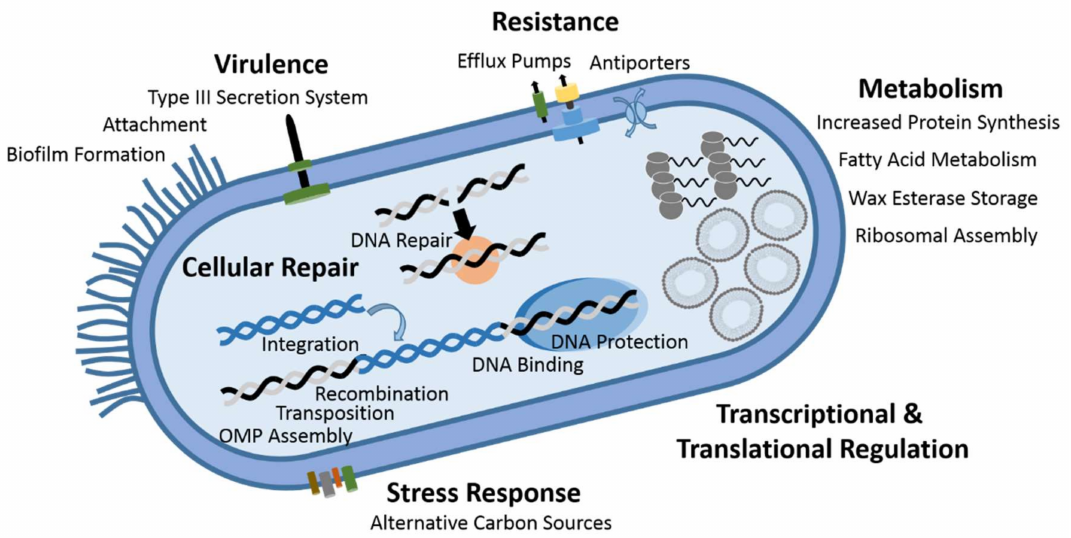
Figure 7. Classifications of upregulated genes in Acinetobacter junii in response to wastewater